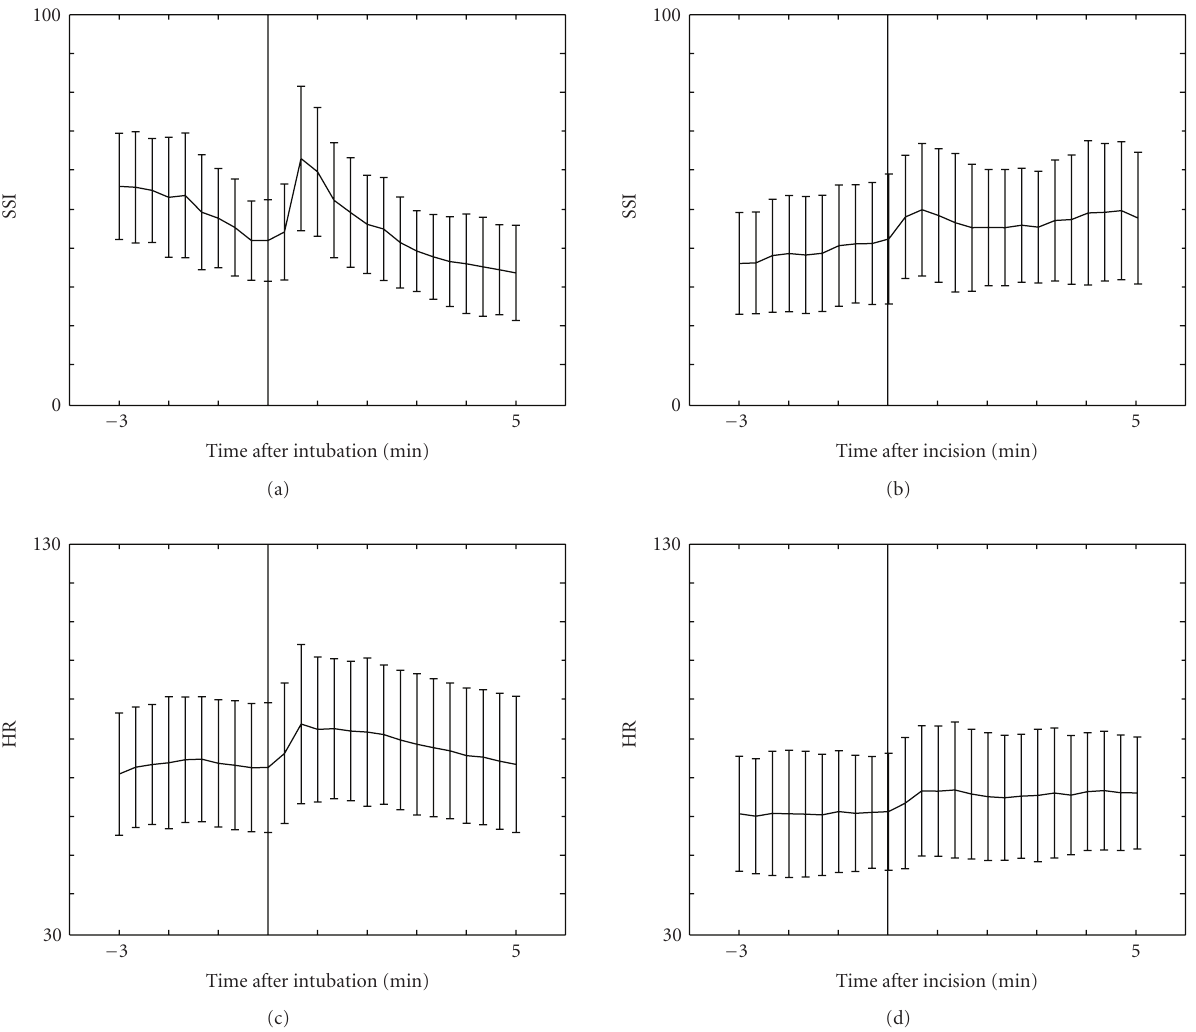
Figure 1: Mean surgical stress index (SSI ± SD) and heart rate (HR ± SD) values before and after tracheal intubation and skin incision.